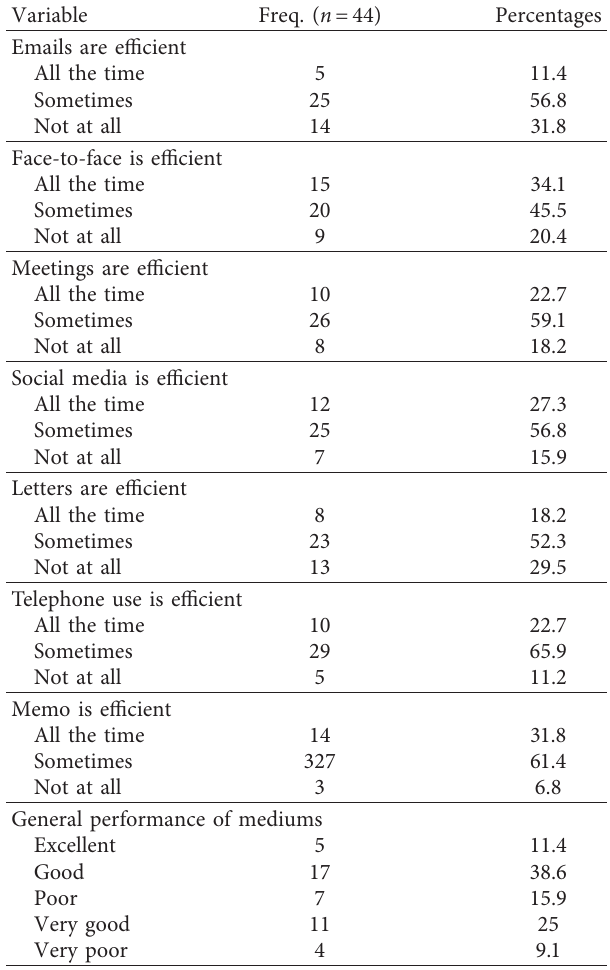
Table 4: Communication mediums effectiveness as examined by